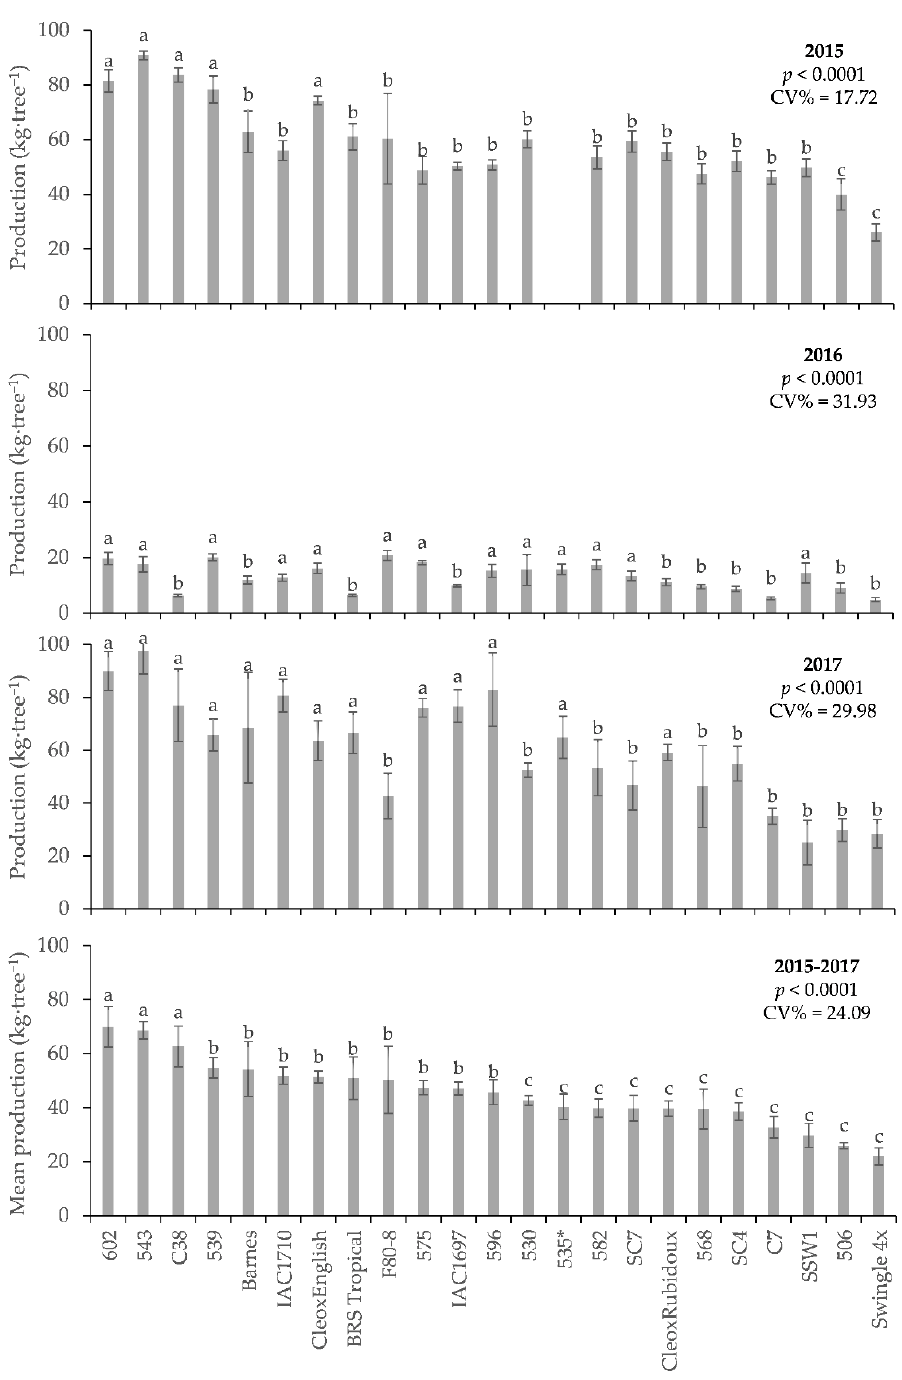
Figure 1. Fruit yield per tree in 2015, 2016 and 2017, and mean fruit yield in the 2015–2017 period, five to seven years after the planting of Valencia sweet orange [ Citrus × sinensis (L.) Osbeck] grafted onto 23 rootstocks and cultivated without irrigation in Northwestern S ã o Paulo State, Brazil. Means followed by the same letters belong to the same group by the Scott-Knott test ( p ≤ 0.05). The bar indicates the standard error of the mean. Rootstock acronyms according to Table 1. * Not evaluated in 2015. BRS Sunki Tropical is the control treatment.